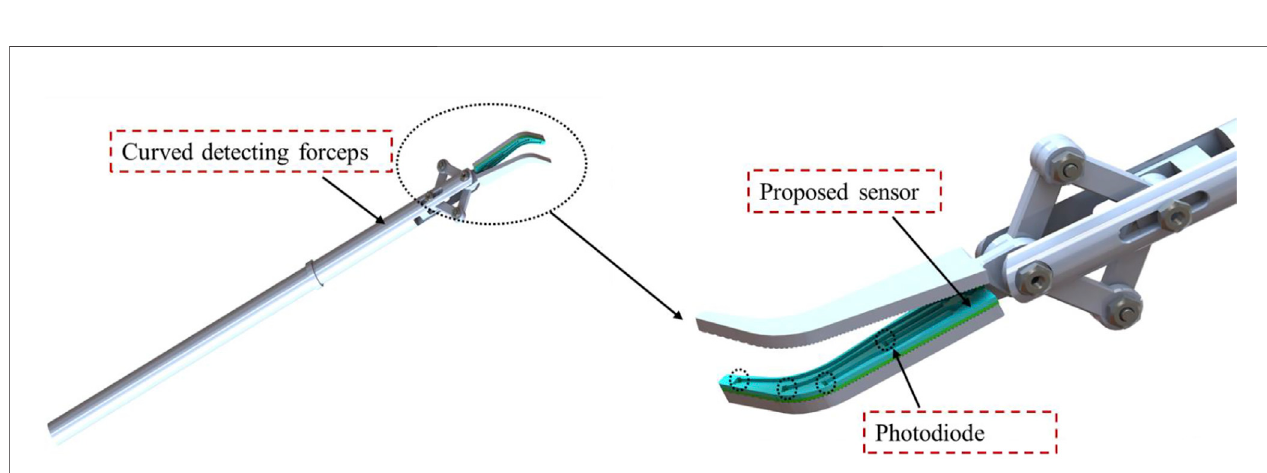
FIGURE 12 | Proposed design for future